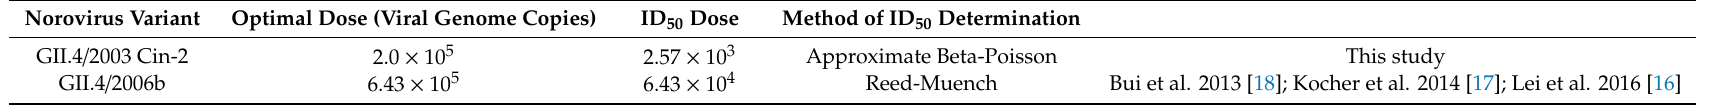
Table 5. Comparison of Cin-2 to GII.4 / 2006b challenge pool used in previous Gn pig